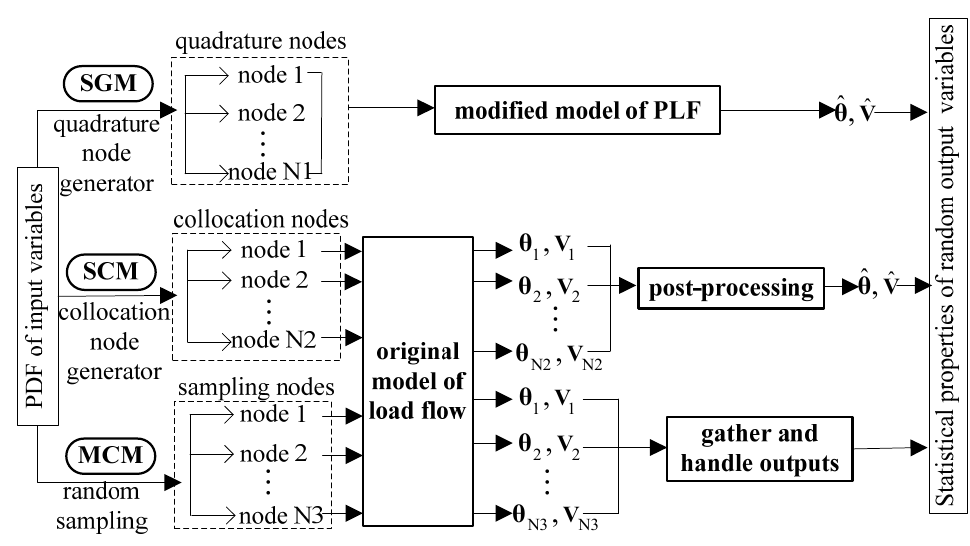
Figure 4. Calculation procedure of PLF by SGM, SCM and MCM.